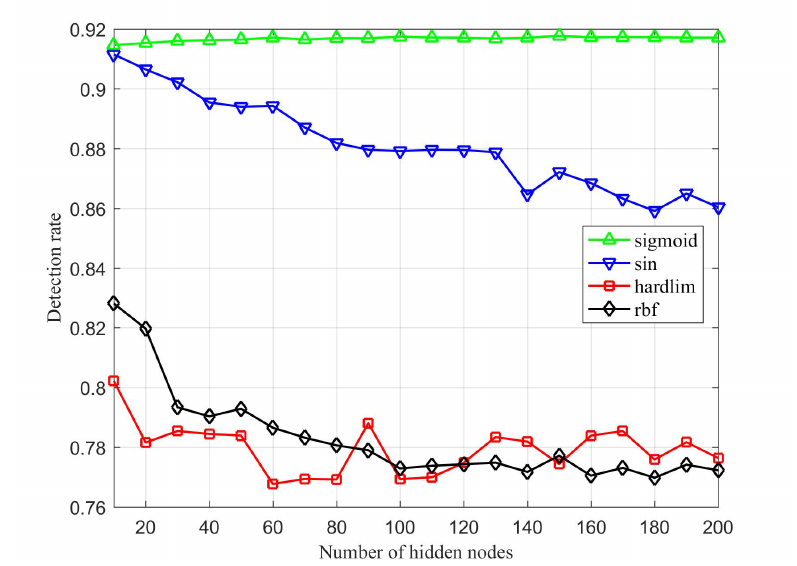
Figure 8. Detection rate of ILECA under different activation